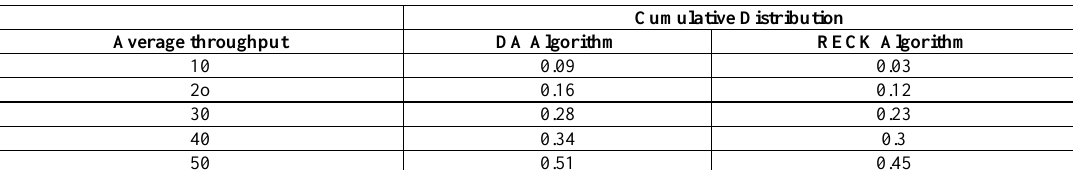
Table 2. Illustration of the data comparison on the basis of throughput